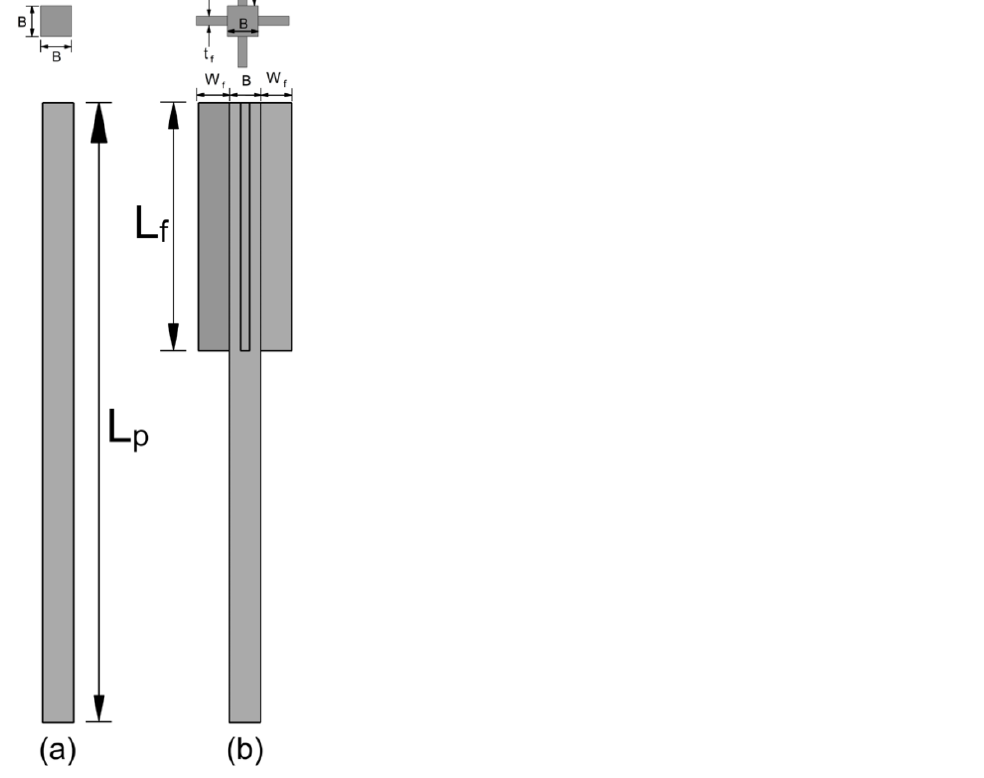
Figure 6. Schematic representation of the pile models: ( a ) regular pile and ( b ) finned pile.